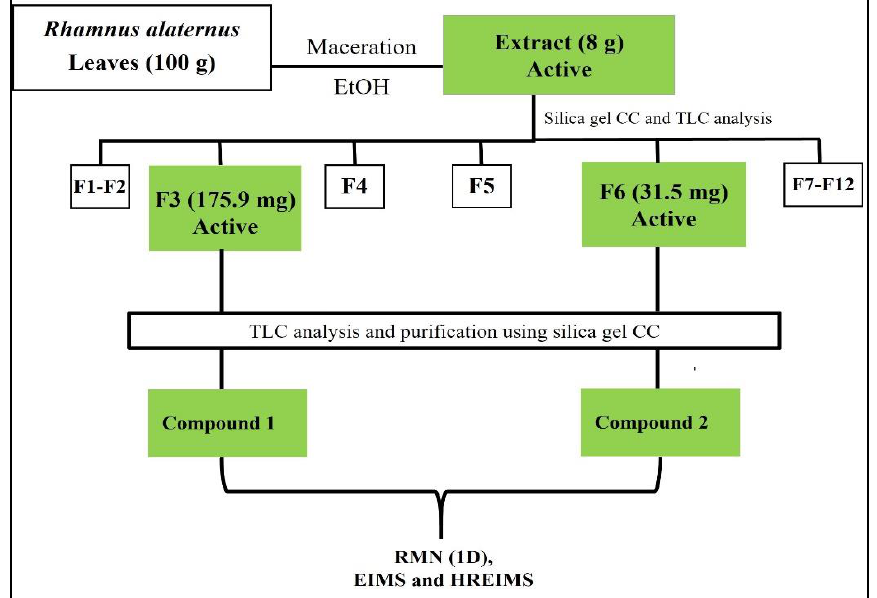
Figure 1. Flowchart of anti-staphylococcal bio-guided fractionation of R. alaternus leaves.